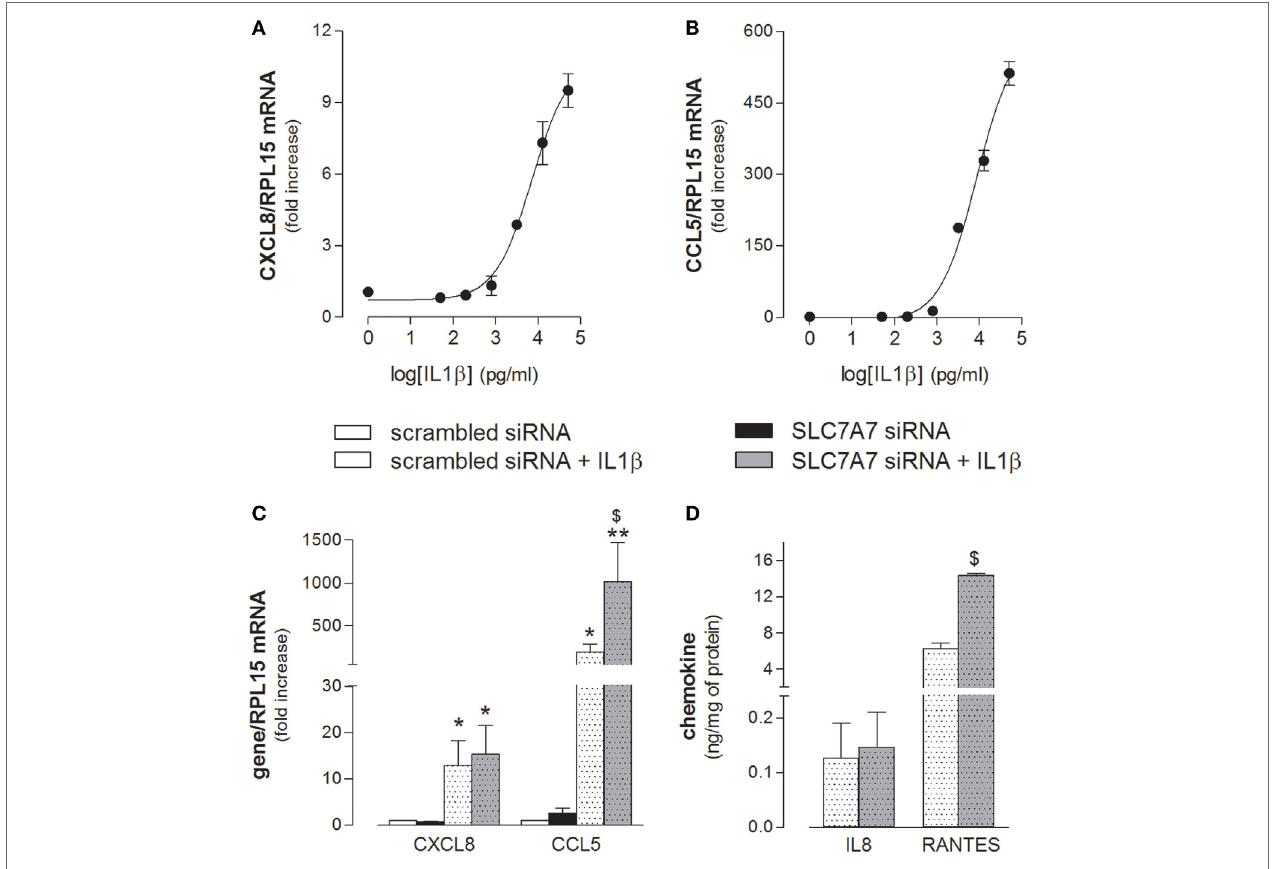
FigUre 6 | (a,B) A549 cells were incubated in the presence of the indicated concentrations of IL1 β ; after 24 h, the expression of CXCL8/IL8 and CCL5/RANTES was monitored with RT-qpolymerase chain reaction (RT-qPCR). Representative experiments are shown. (c,D) A549 cells were transfected with scrambled or SLC7A7 short interference RNA (siRNA) for 96 h (see Materials and Methods); where indicated, IL1 β (10 ng/ml) was added to the incubation medium for the last 24 h; at the end, the expression and release of the indicated chemokines was monitored at mRNA (c) and protein (D) level with RT-qPCR and ELISA, respectively. Data are mean ± SEM of three independent determinations, each performed in duplicate. * p < 0.05, ** p < 0.01 vs . scrambled siRNA; $ p < 0.05 vs. scrambled siRNA + IL1 β with one-way ANOVA followed by Bonferroni post hoc